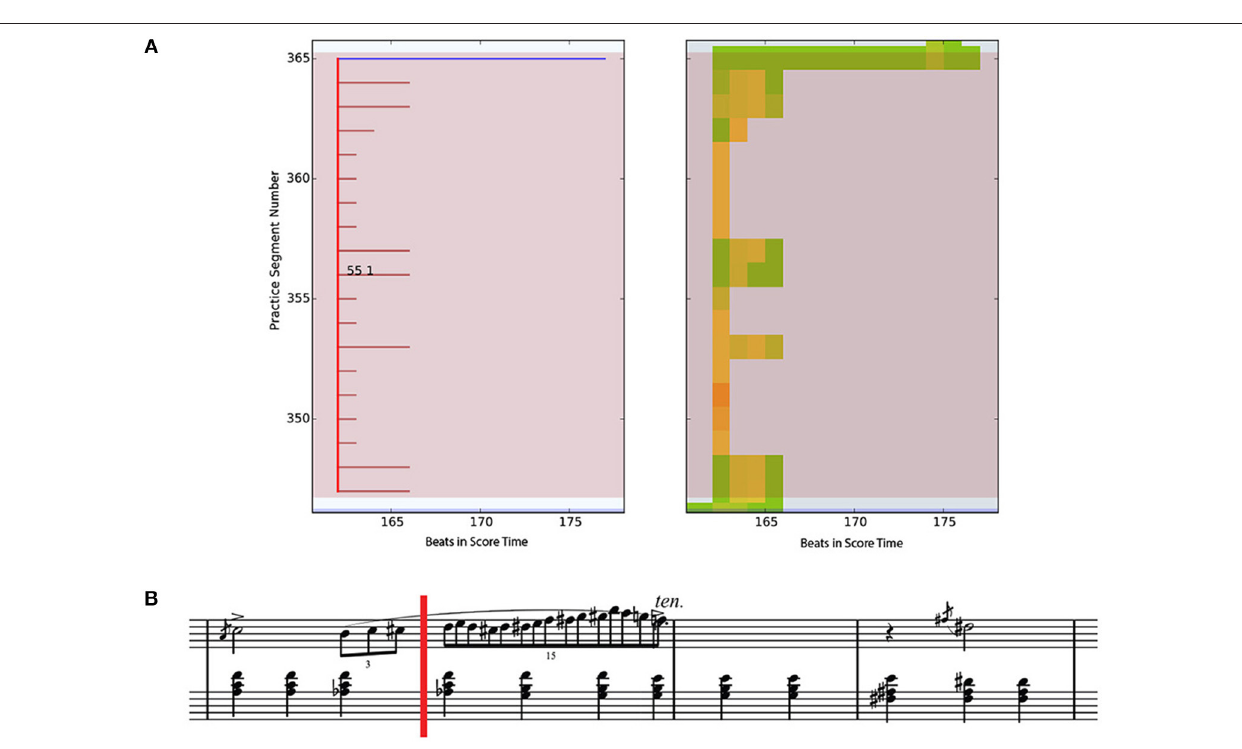
Frontiers in Psychology | www.frontiersin.org